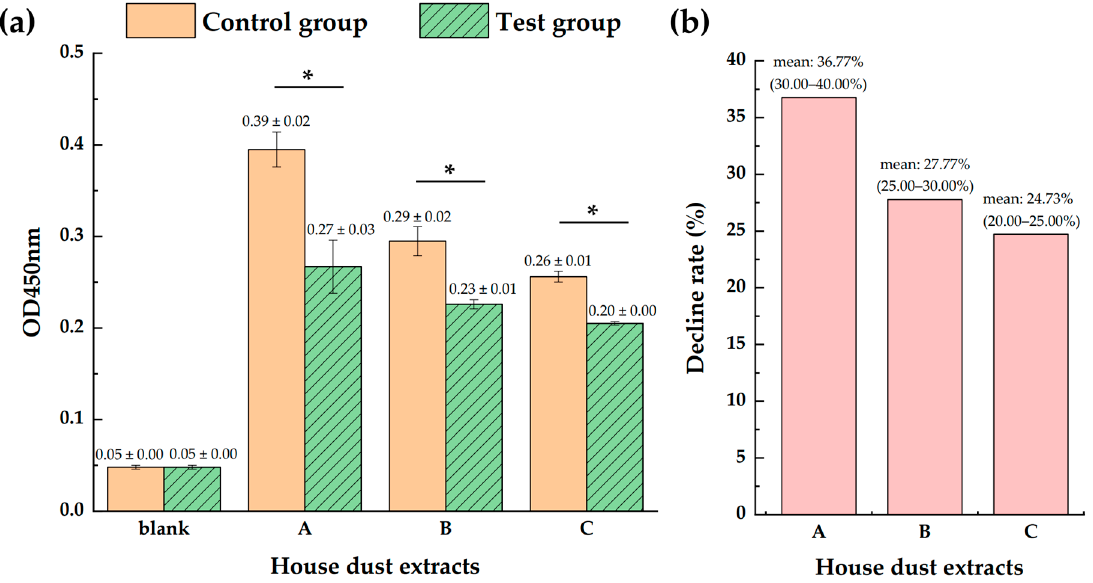
Figure 1. Lowered content of allergens Der f 1 and Der p 1 in house dust extracts using todomatsu oil ( a ) and the decline rates ( b ) were analyzed using ELISA. Test group: the 6-times diluted house dust extracts (No. A, No. B, No. C), with a concentration that is higher than the sensitization threshold (2 μ g/g) [39–43] before dilution, exposed to todomatsu oil atmosphere (0.1 μ L/cm 3 ) for 2 h at 25 °C. Control group: their counterpart in the same given condition yet without oil. The value is the mean ± SD from three independent replicates of each sample. * signifies a significant difference ( p < 0.05).